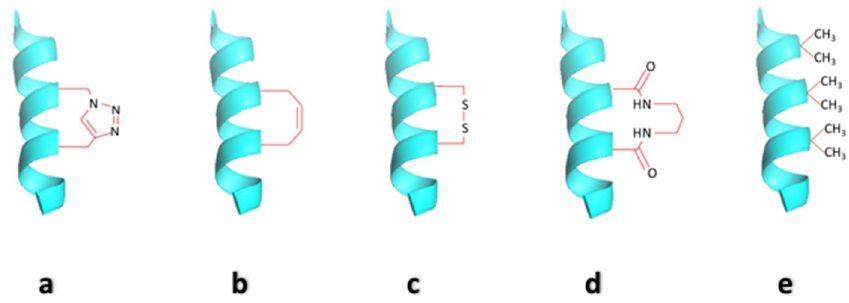
Figure 1. Different α -helix-stabilization methods for small peptides. For cross-linked peptides, all are between residues i and (i + 4). ( a ) Triazole stapled helix; ( b ) Hydrocarbon stapled helix; ( c ) di-sulfide cross-linked helix; ( d ) Lactam cross-linked helix; ( e ) Aib substituted helix.